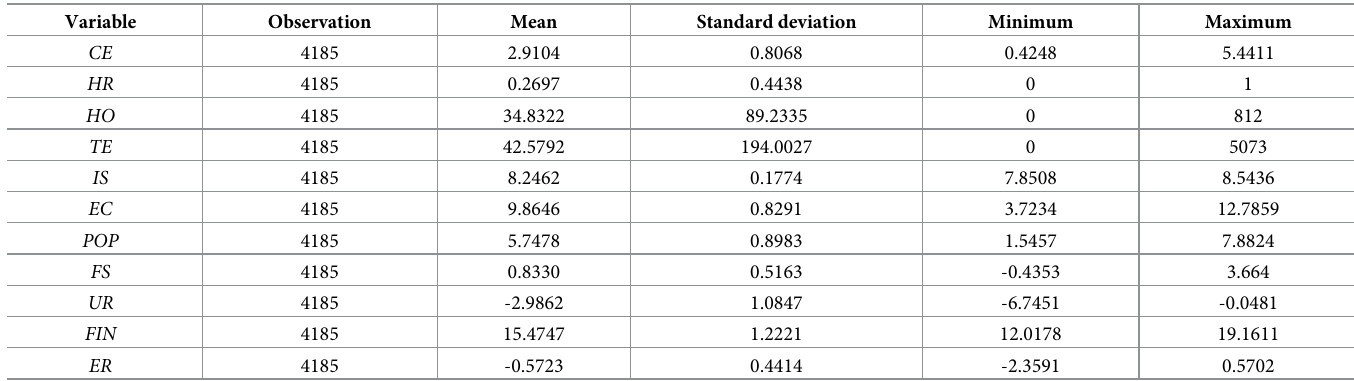
Table 1. Descriptive statistics of